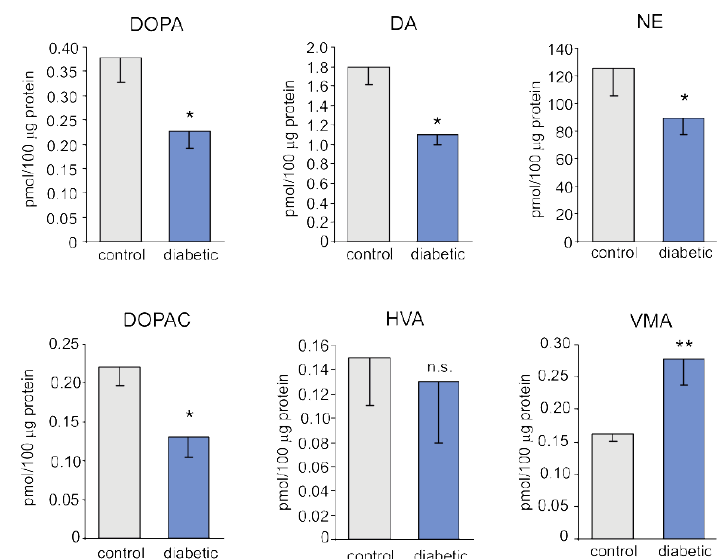
Figure 2. The content (per 100 μg of protein) of catecholamines and their metabolites in the pineal glands of control and diabetic pigs. The values presented are means and standard errors ( n = 5). The means significantly different from those of the control group are marked with asterisks; single asterisk (*) indicates p < 0.05, double asterisk (**) represents p < 0.01, n.s. indicates non-significant. Abbreviations: DOPA, 3,4-dihydroxyphenylalanine; DA, dopamine; NE, norepinephrine; DOPAC, 3,4-dihydroxyphenylacetic acid; VMA, vanillylmandelic acid; HVA, homovanillic acid.